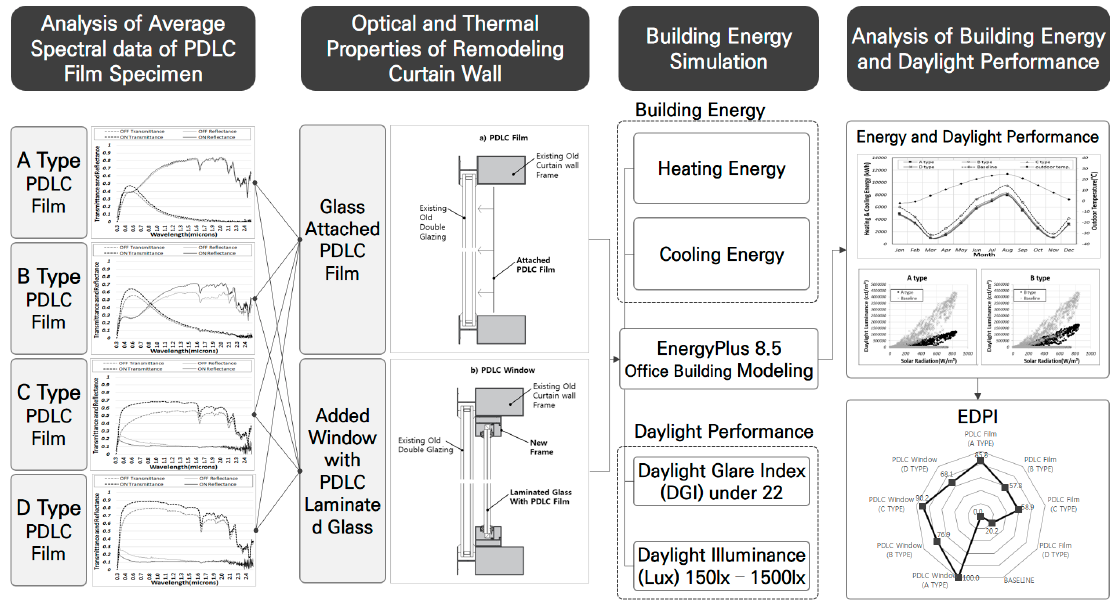
Figure 1. Research guideline and flowchart.